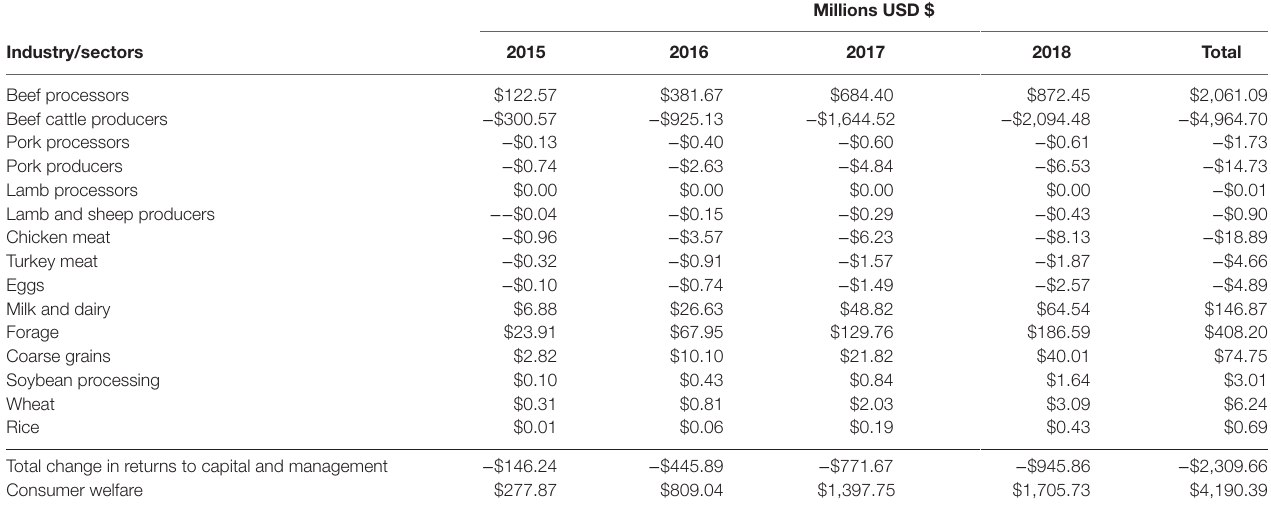
TaBle 4 | Economic impacts for change in returns to capital and management and consumer welfare resulting from reduction in BRD